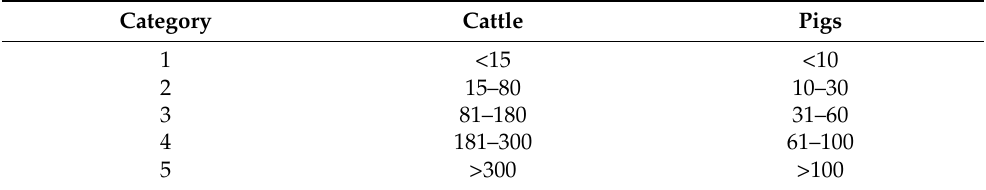
Table 3. Categorization of veterinary practices based on the number of farm relations. Category Cattle Pigs 1 <15